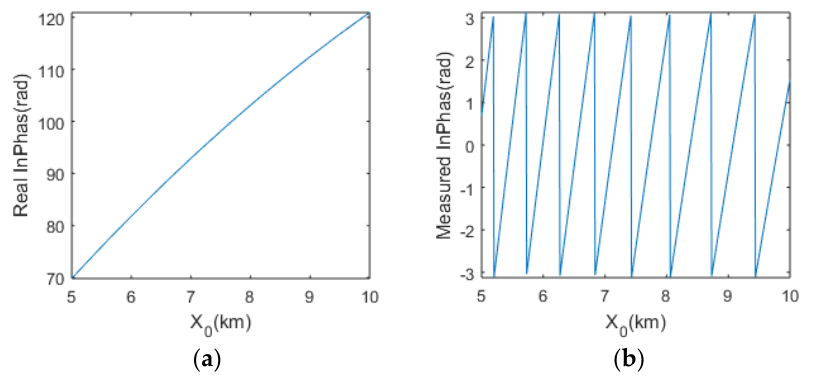
Figure 2. The influence of the squint effect on InPhas: ( a ) the real InPha; ( b ) the measured InPhas.